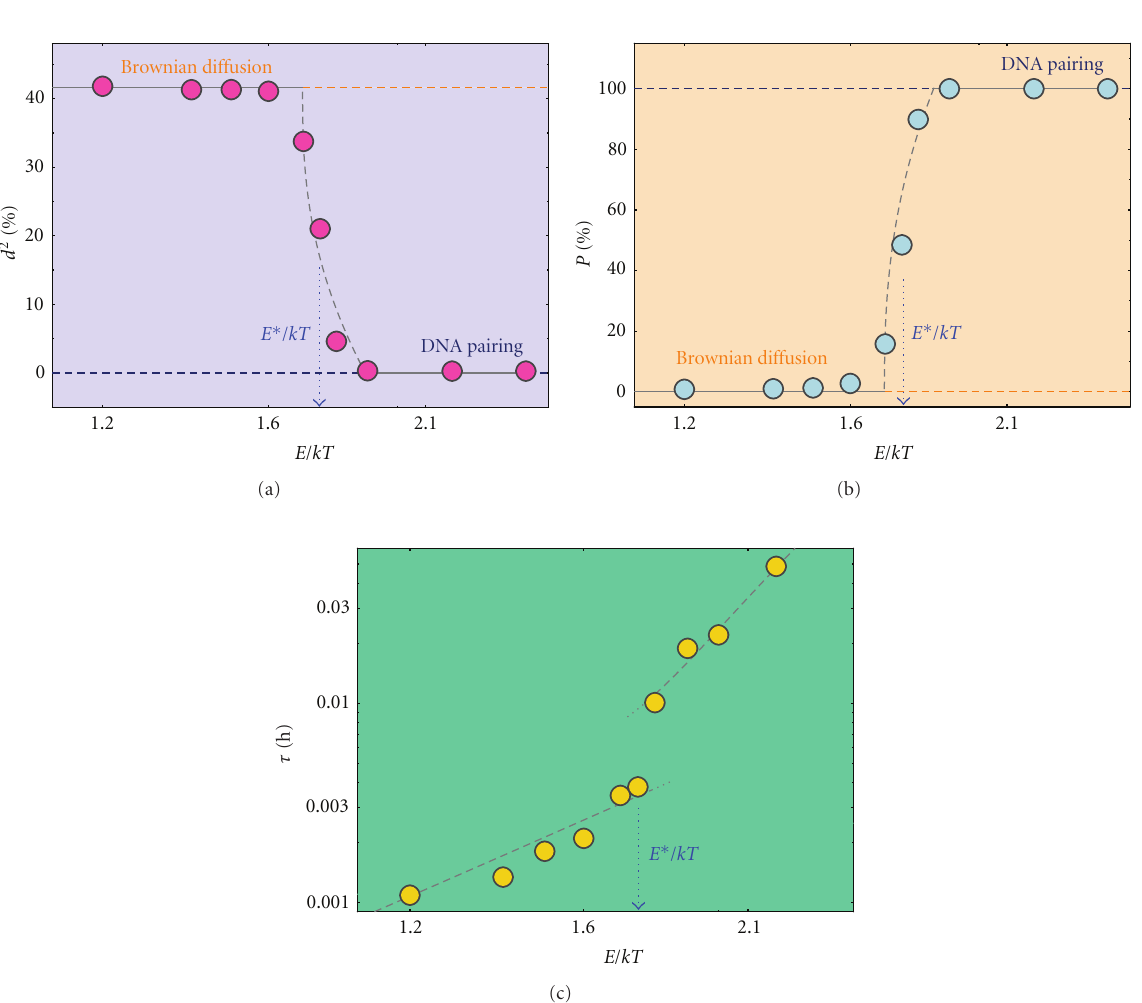
Figure 3: DNA loci colocalization is the result of a thermodynamic phase transition. We show this through the plots of the normalized mean square distance ( d 2 , (a)) and of the fraction of paired DNA loci ( P , (b)) at equilibrium, as functions of E , the interaction energy between the molecular factors (MFs) and the DNA binding sites (BSs). As E increases, d 2 and P , from values typical of Brownian di ff usion ( d 2 ∼ 40% and P ∼ 0%, orange horizontal lines), rapidly saturate to values which signal DNA loci full colocalization ( d 2 ∼ 0%, P ∼ 100%, blue horizontal lines), after a threshold value E ∗ /kT = 1 . 75 (defined by the criterion P ( E ∗ ) = 50%). Superimposed fits for both d 2 ( E ) and P ( E ) are power-law functions (gray dashed lines). In (c) the characteristic time scale τ needed to reach thermodynamic equilibrium is illustrated, as function of E . τ ( E ) turned out to be an increasing function, as the stronger MF-BS bonds make the DNA loci di ff usion more di ffi cult. A “jump” is observed at E ∗ , when the phase transition takes place. The superimposed fits are power-law functions. We took an MF concentration c = 0 . 2% and a DNA BS number n 0 =